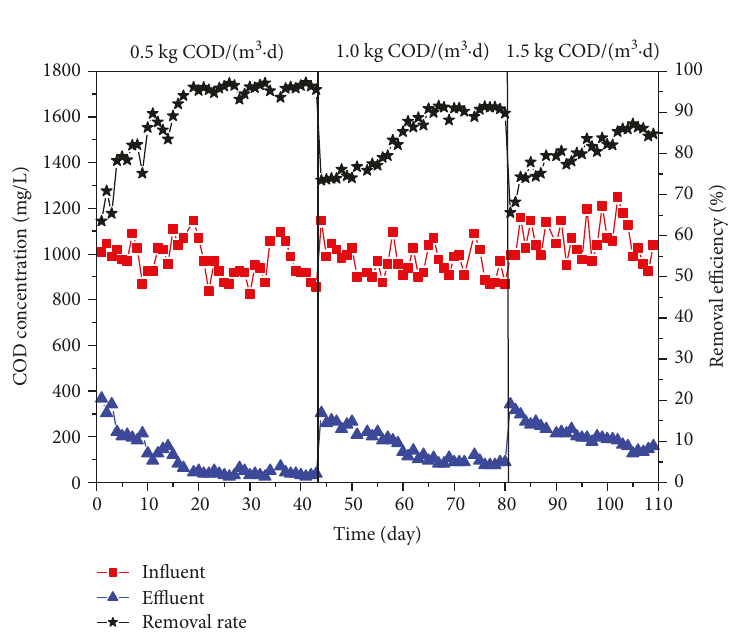
Figure 2: COD concentration variations in in fl uent and e ffl